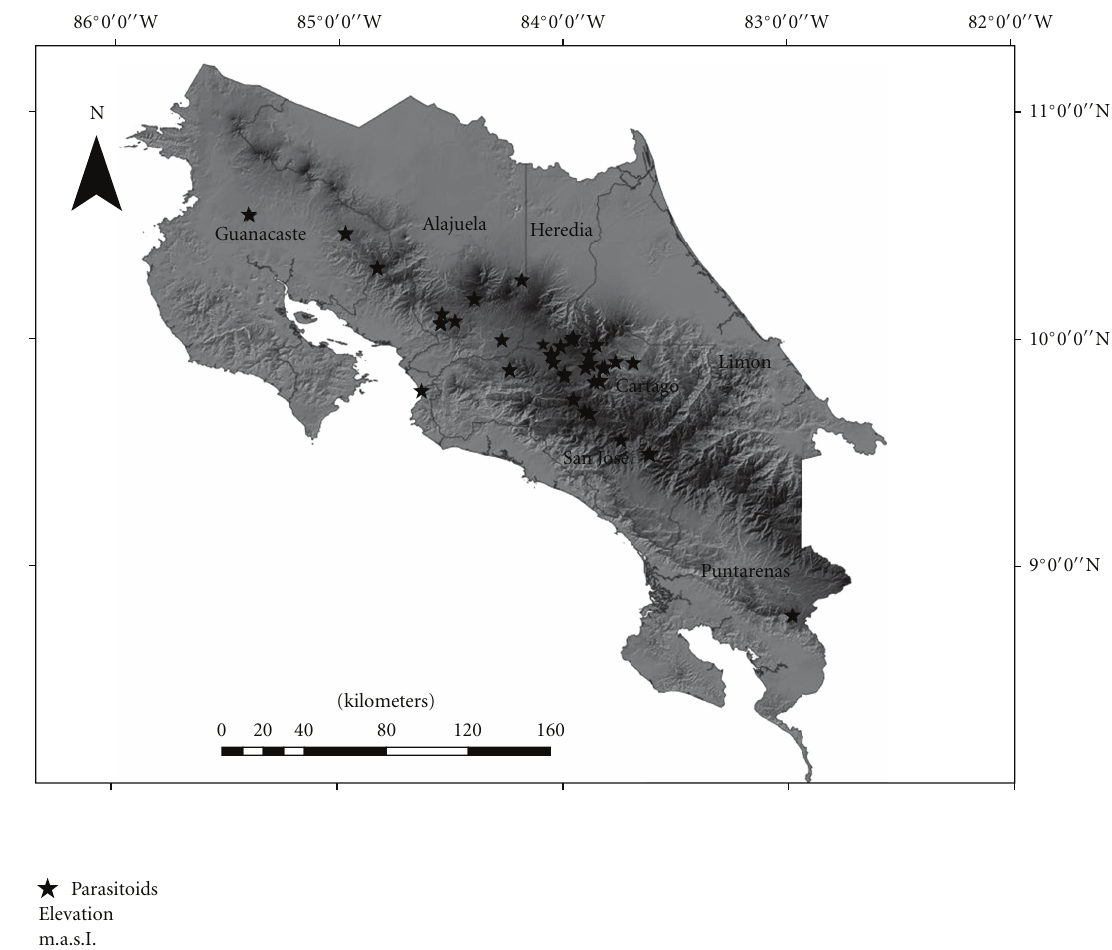
Figure 1: Geographic distribution of aphid-Aphidiinae associations in Costa